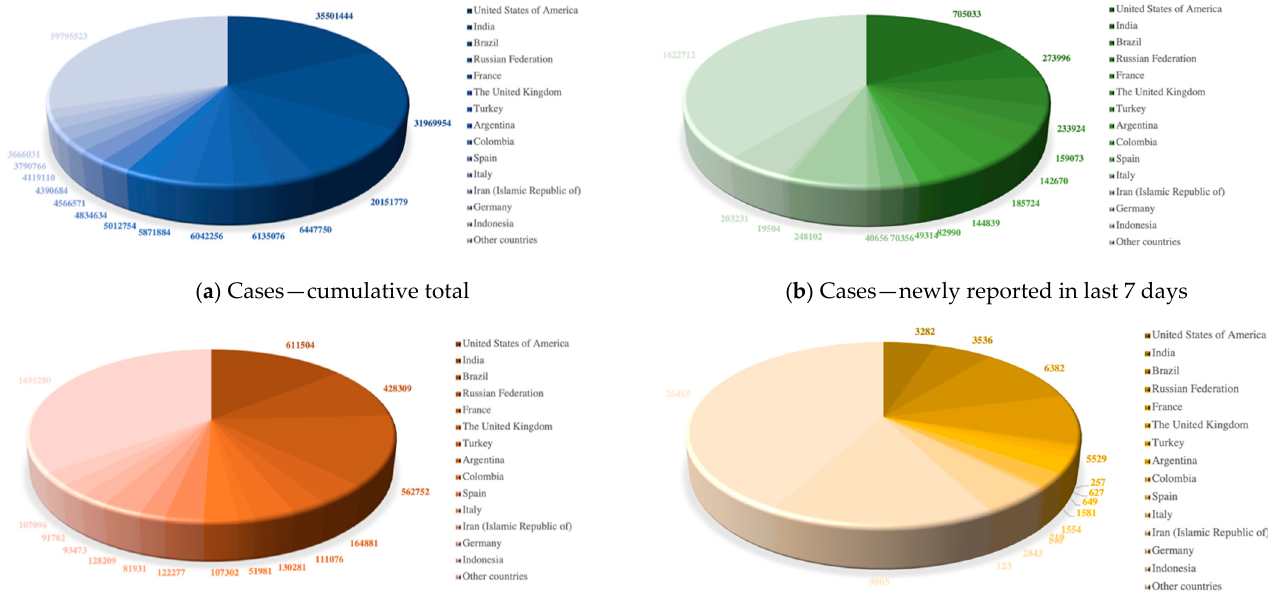
Figure 1. WHO Coronavirus (COVID-19) Dashboard.